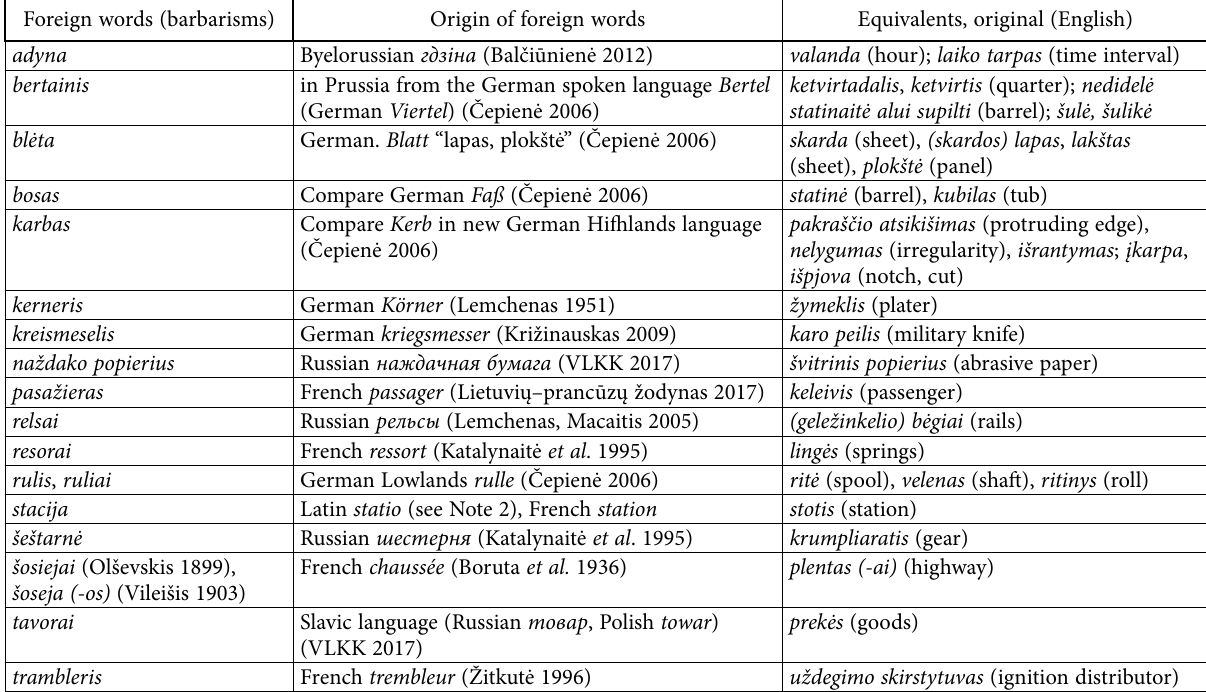
Table 1. Foreign words from the sources of the end of the 19th century and the beginning of the 20th century Foreign words